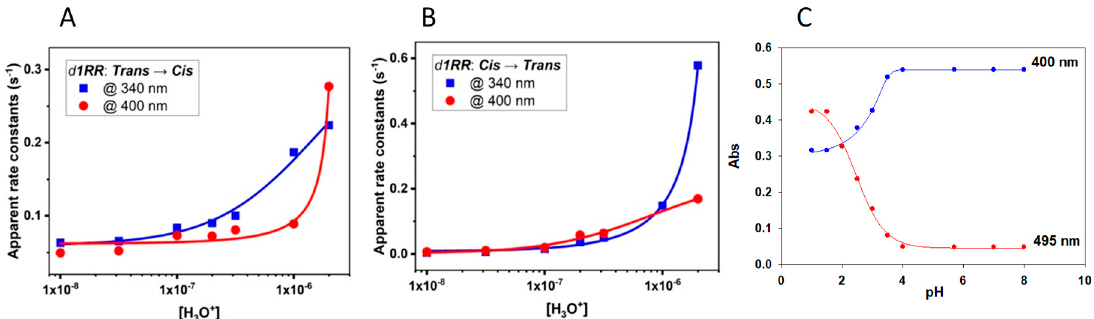
Figure 4. Changes in the apparent rate constants versus pH in the 5.7–8.0 range. ( A ) d 1RR trans → cis (irradiated at 435 nm). ( B ) d 1RR cis → trans (thermal decay). Both the transitions were monitored at 400 nm (circle) and 340 nm (square). Data coming from interpolations of the data are reported in Table S1. ( C ) Titration curve of d 1RR in phosphate buffered solution obtained plotting the absorptions at 400 and 495 nm versus pH.